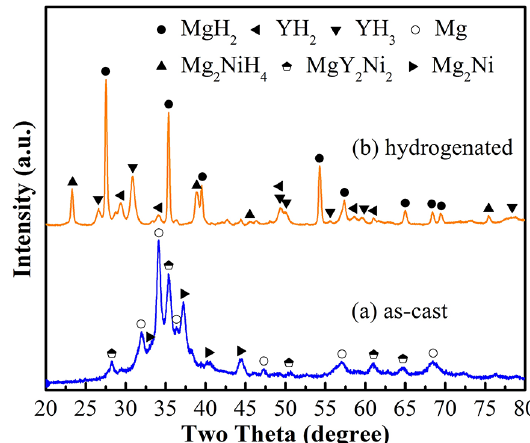
YNi alloy as-cast (a) and 10